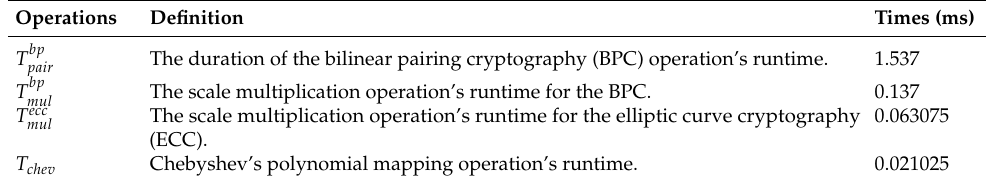
Table 3. Time Required for Various Cryptographic Operations.